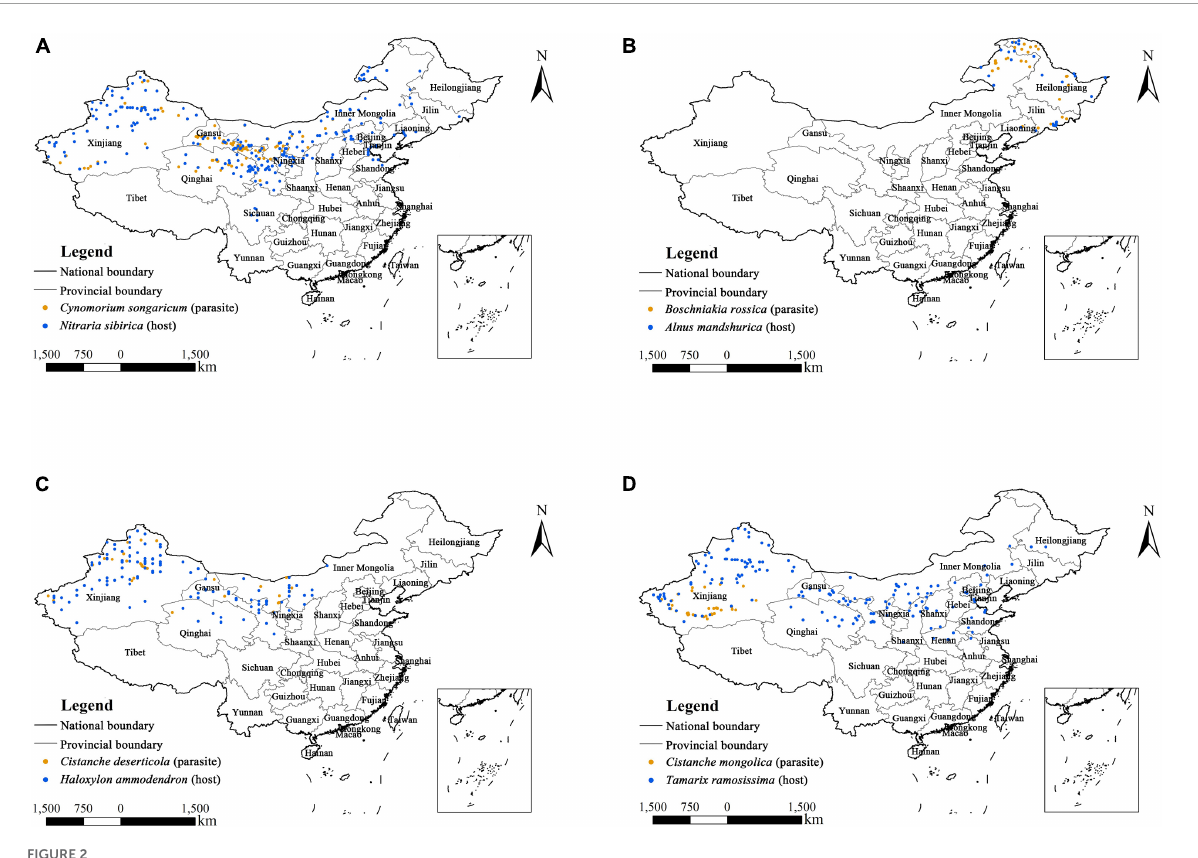
FIGURE2 Occurrence records of four holoparasitic plants and their primary hosts in China. (A) Cynomorium songaricum and Nitraria sibirica ; (B) Boschniakia rossica and Alnus mandshurica ; (C) Cistanche deserticola and Haloxylon ammodendron ; (D) Cistanche mongolica and Tamarix ramosissima